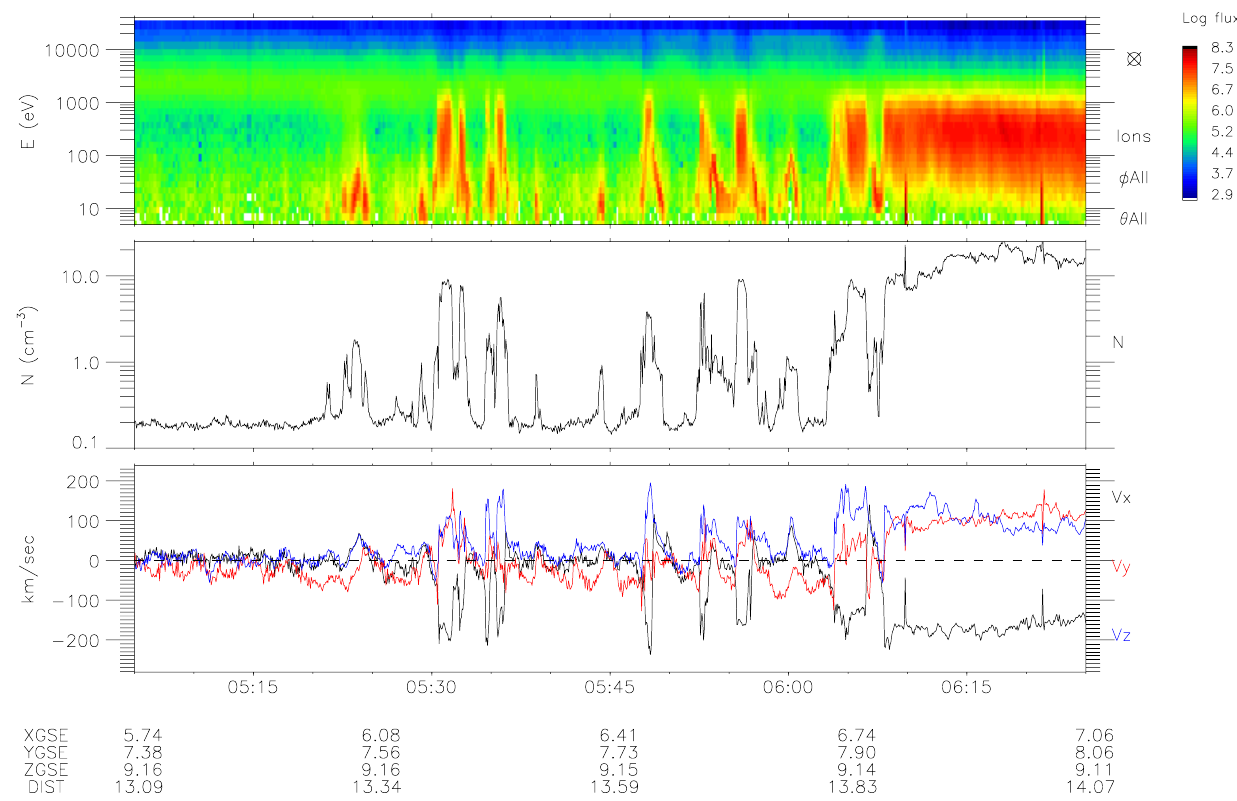
Fig. 2. Overview of the ion measurements (without mass resolution) on board Cluster #3 on 31 January 2001 between 05:05 and 06:25UT. From top to bottom: ion energy-time spectrogram with color-coded fluxes, (cm 2 .s.ster.keV) − 1 ; density and the three GSE components of the ion velocity vector. The moments are computed on